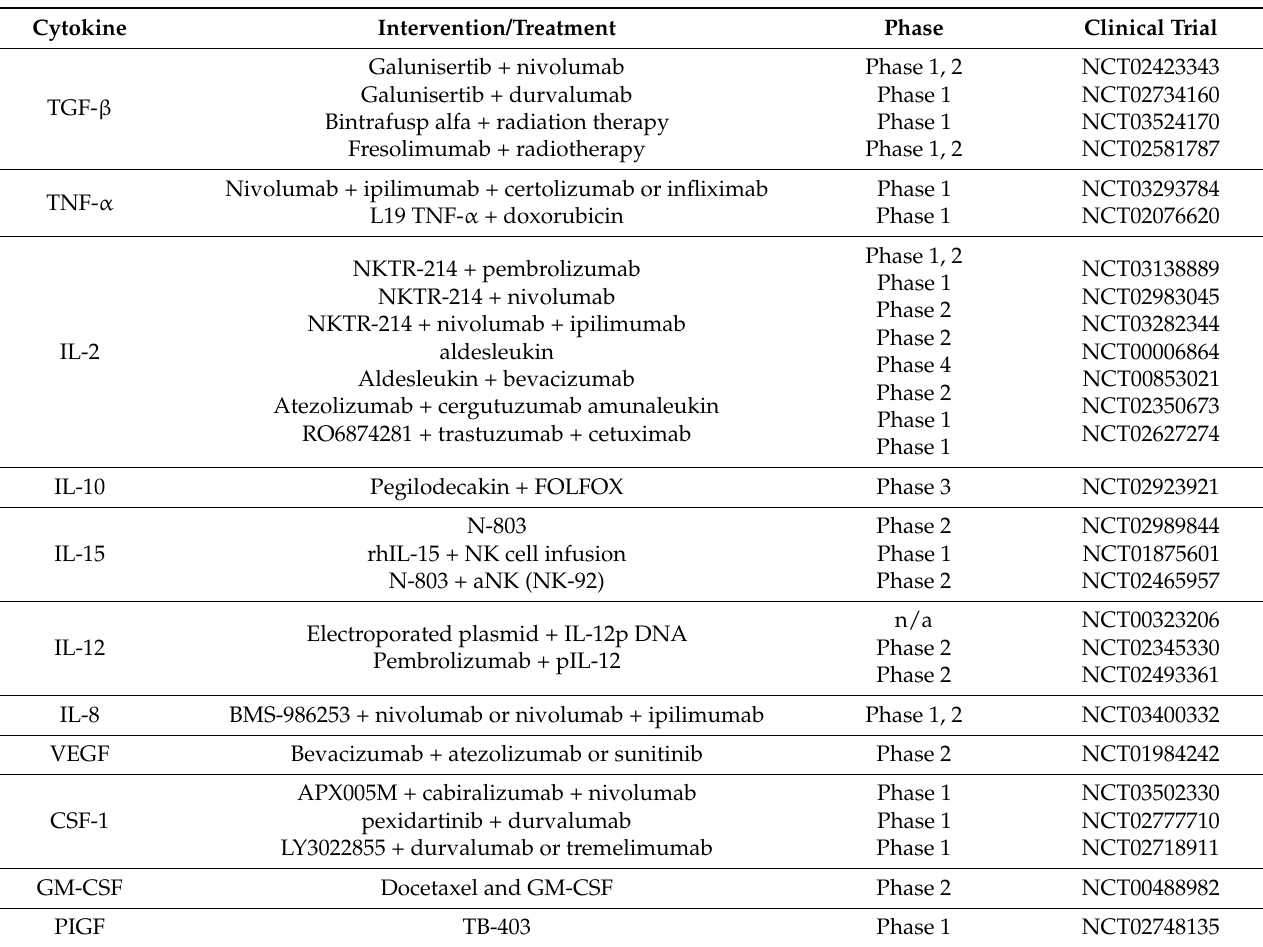
Table 1. Representative clinical trials: cytokine targeted immunotherapy strategies in monotherapy or combination (as of April 2022) may prove promising for the treatment of various